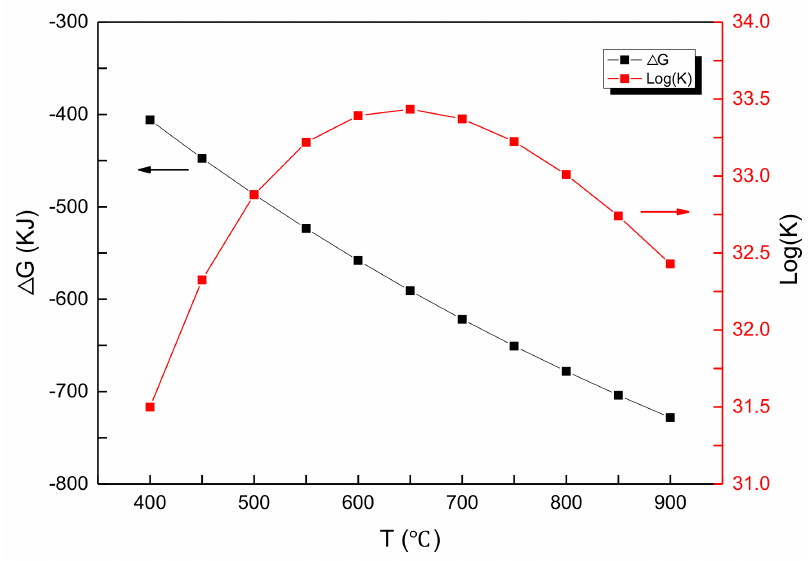
Figure 3. The dependence of ∆ G and log(K) of Equation (2) with reaction